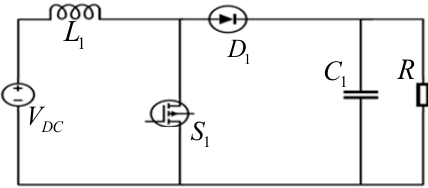
Figure 7. Boost converter circuit diagram.